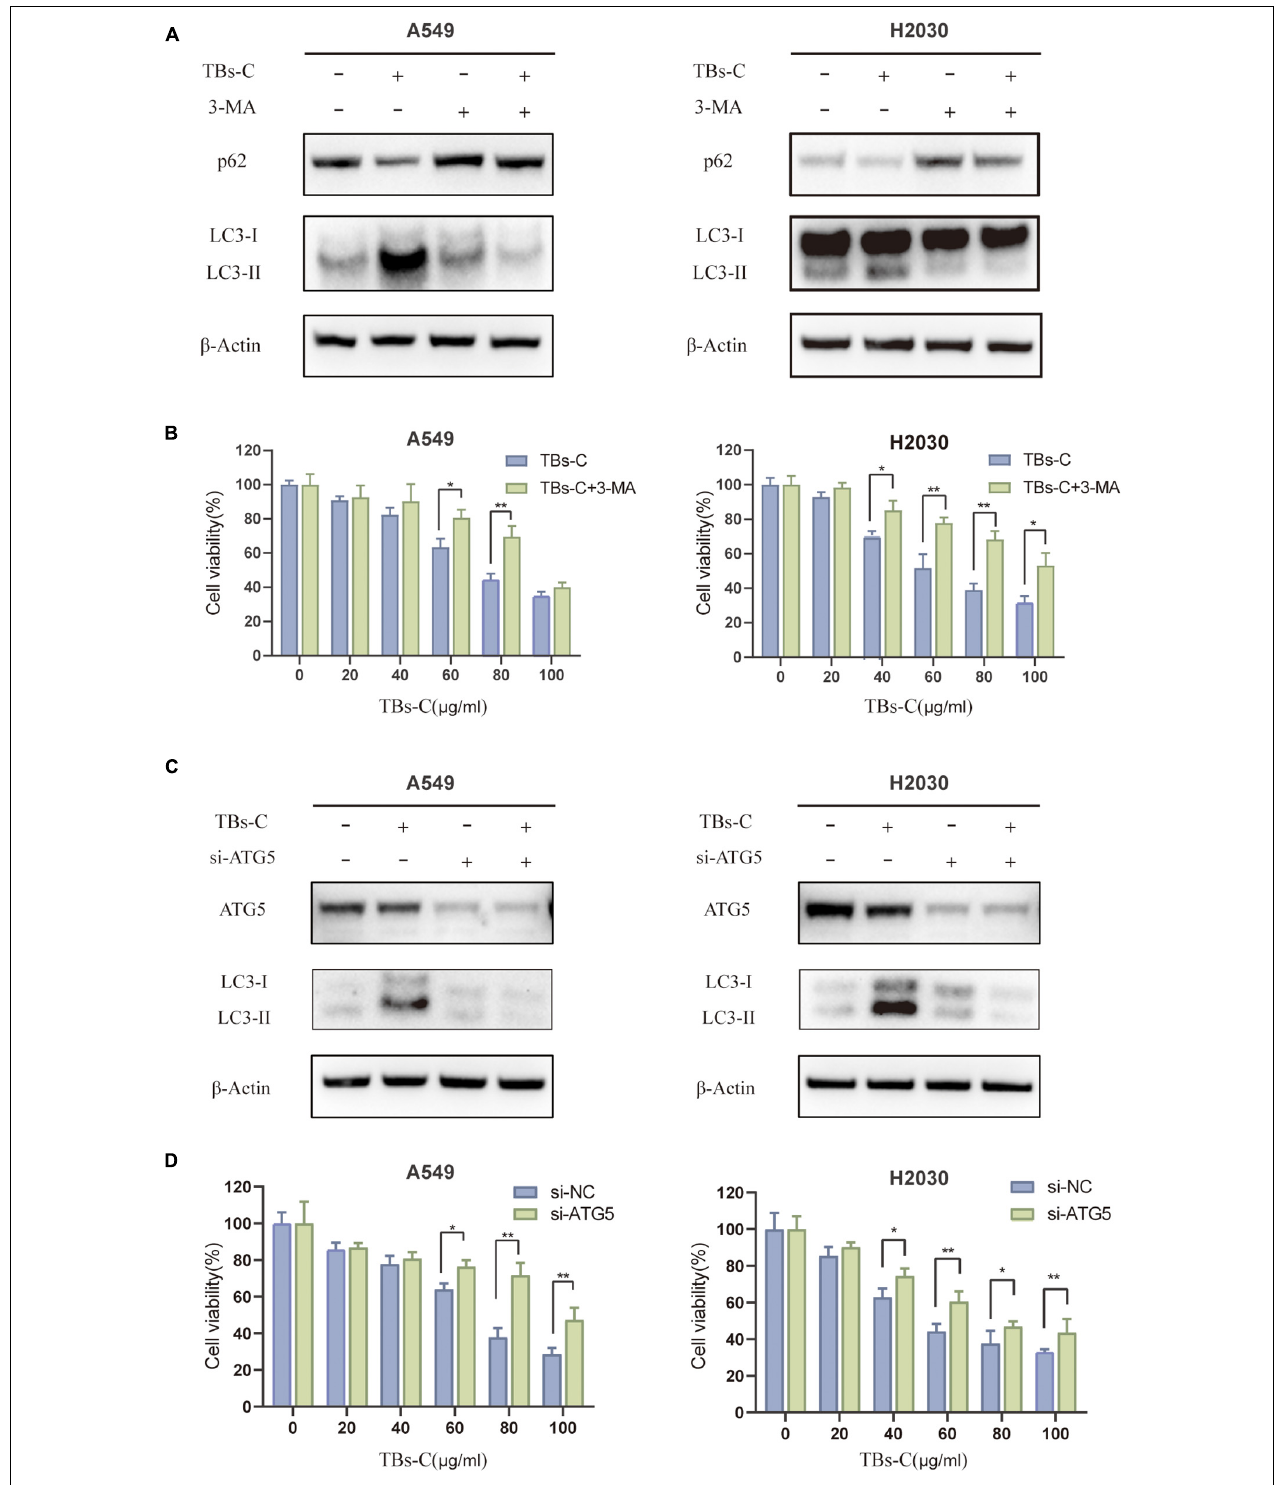
FIGURE 5 | Inhibition of autophagy overcomes the antitumor effect of TBs-C in NSCLC cells. (A) Cells pretreated with or without 3-MA were treated with TBs-C (60 µ g/mL) for 24 h, and the protein levels of LC3 and p62 were detected by Western blotting. (B) Cells pretreated with or without 3-MA were treated with TBs-C for 24 h, and the cell viabilities were determined by the CCK-8 assay. (C) Cells transfected with si-NC and si-ATG5 were treated with TBs-C (60 µ g/mL) for 24 h, and the protein levels of LC3 and p62 were detected by Western blotting. (D) Cells transfected with si-NC and si-ATG5 were treated with TBs-C for 24 h, and the cell viabilities were determined by CCK-8 assay, * p < 0.05, ** p < 0.01.